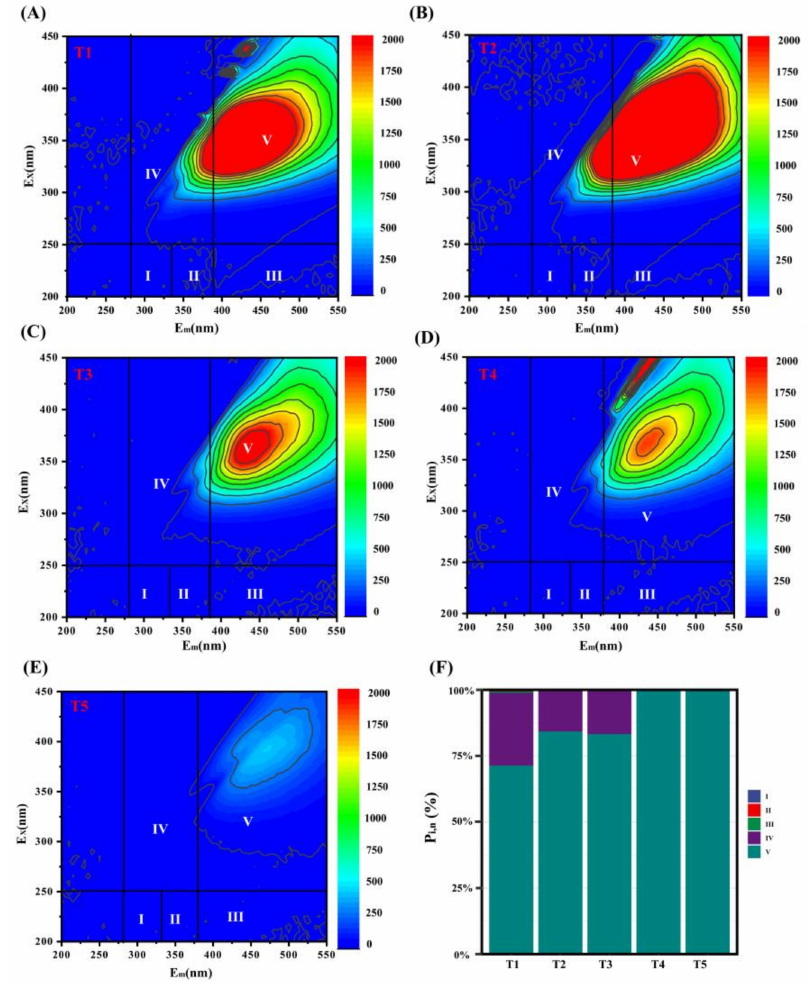
Figure 1. Fluorescence excitation–emission matrix spectra ( A – F ) and distribution of FRI of PA-derived DOM samples at different temperature ranges (T1, 240–270 ◦ C; T2, 270–340 ◦ C; T3, 340–370 ◦ C; T4, 370–400 ◦ C; T5, 400–420 ◦